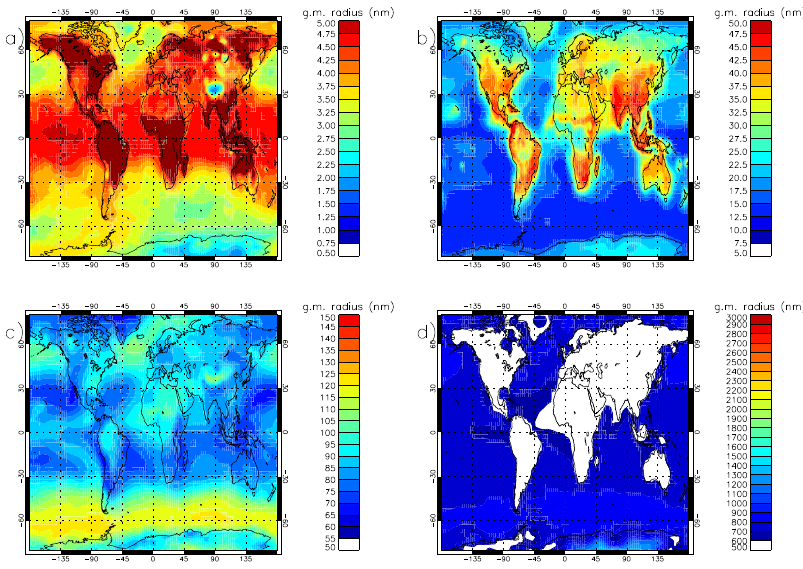
Fig. 10. Global maps of simulated annual-mean geometric mean radius in the lowest model level for (a) nucleation mode, (b) Aitken-soluble mode, (c) accumulation-soluble mode and (d) coarse-soluble